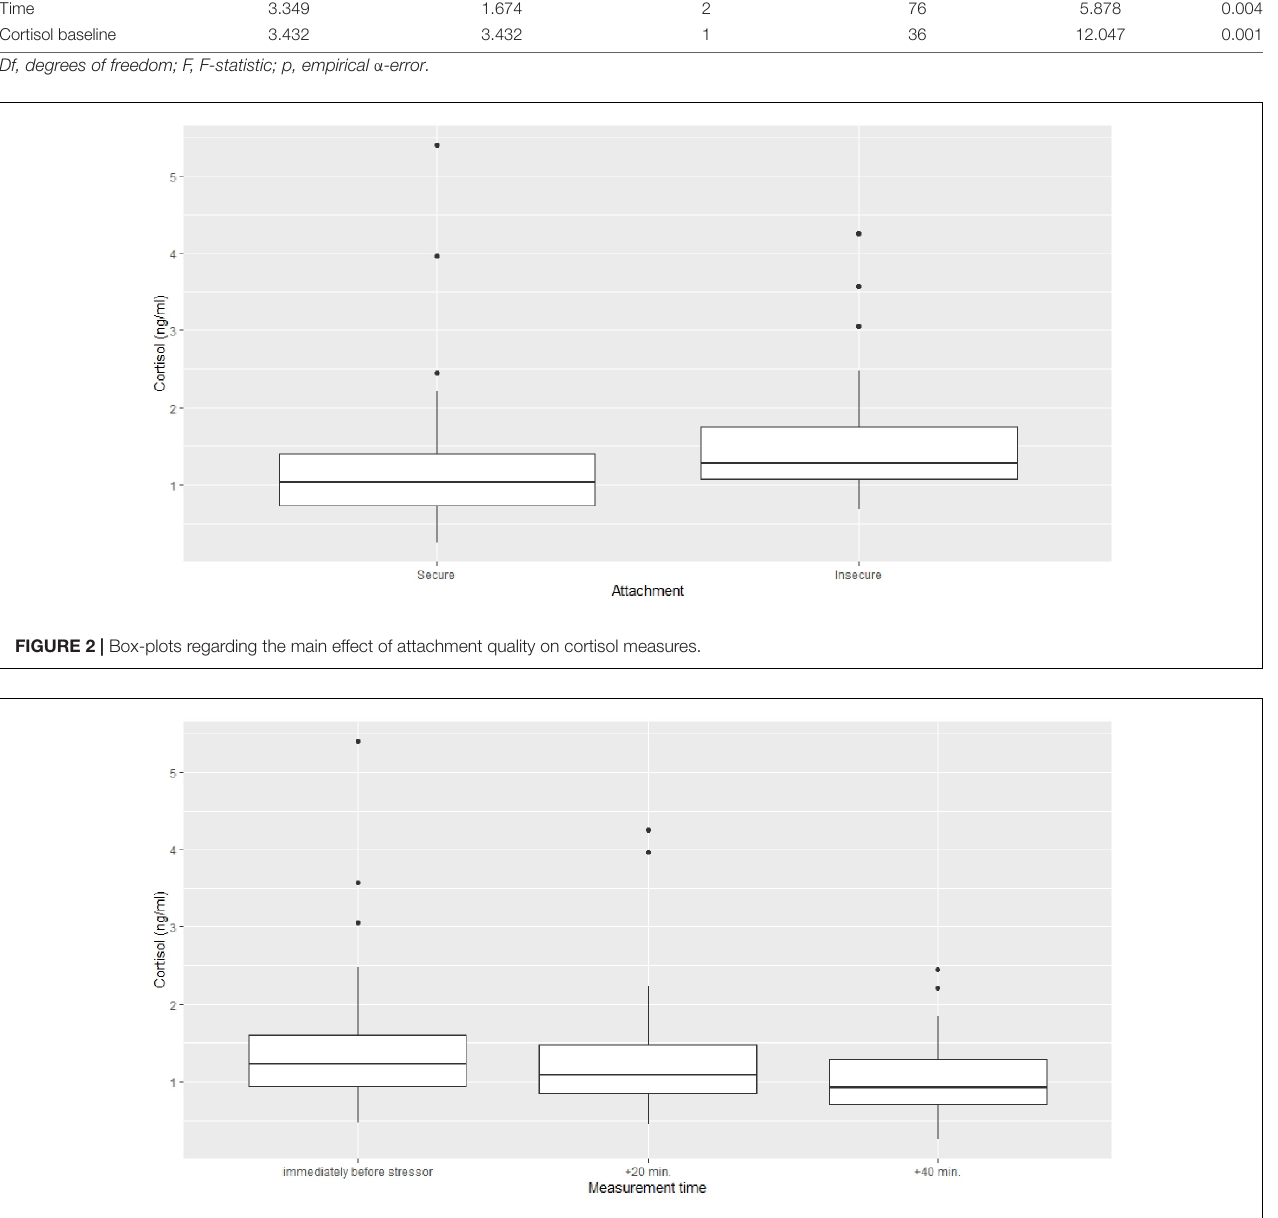
FIGURE 3 | Box-plots regarding the main effect of time on cortisol